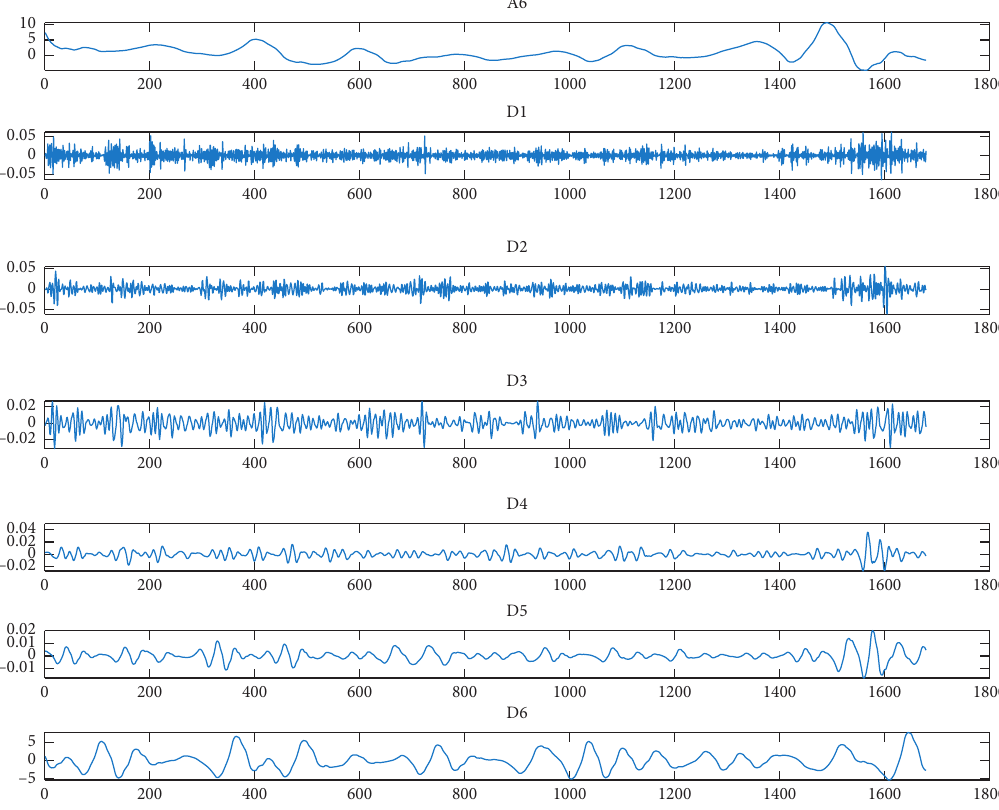
Figure 3: Six-level decomposition of the agriculture index